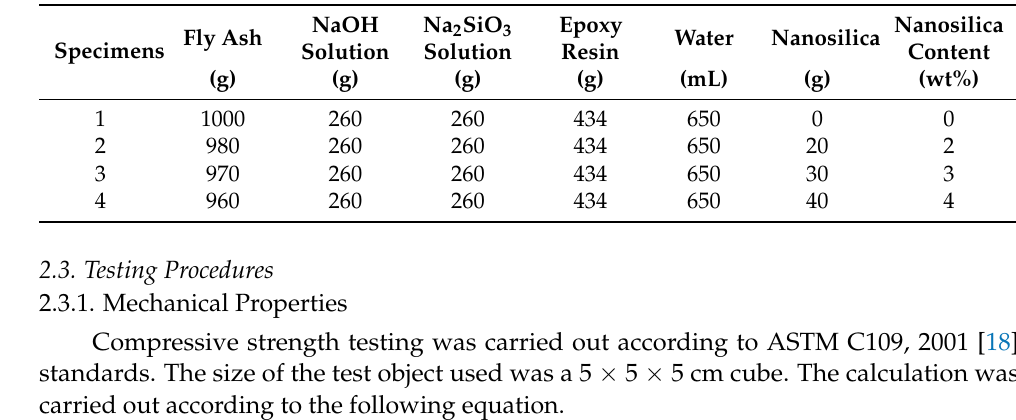
Table 3. Mixture proportions of geopolymers